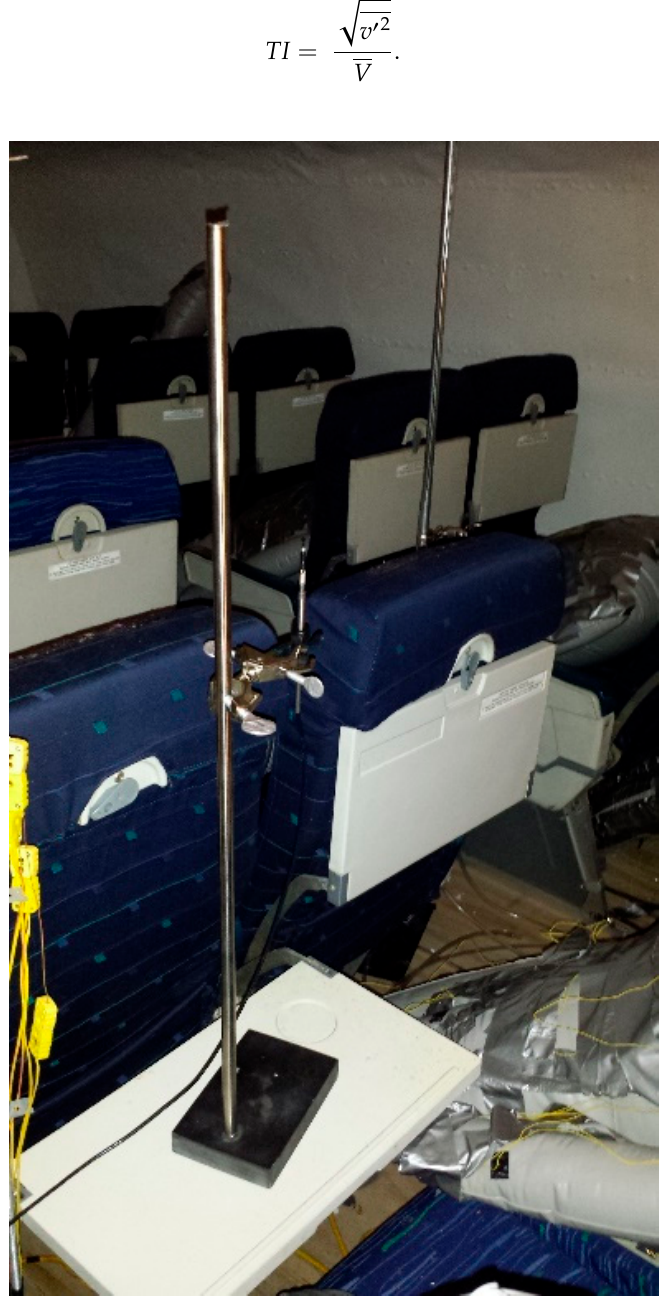
Figure 4. 8475 series TSI speed transducer.